Question: Looking at the figure, what chart type is it?
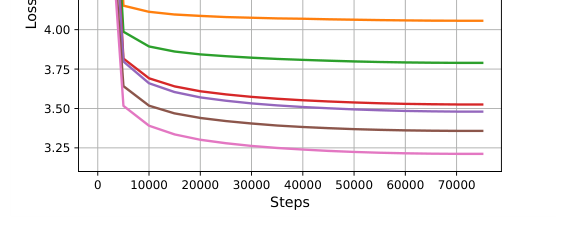
Answer: line